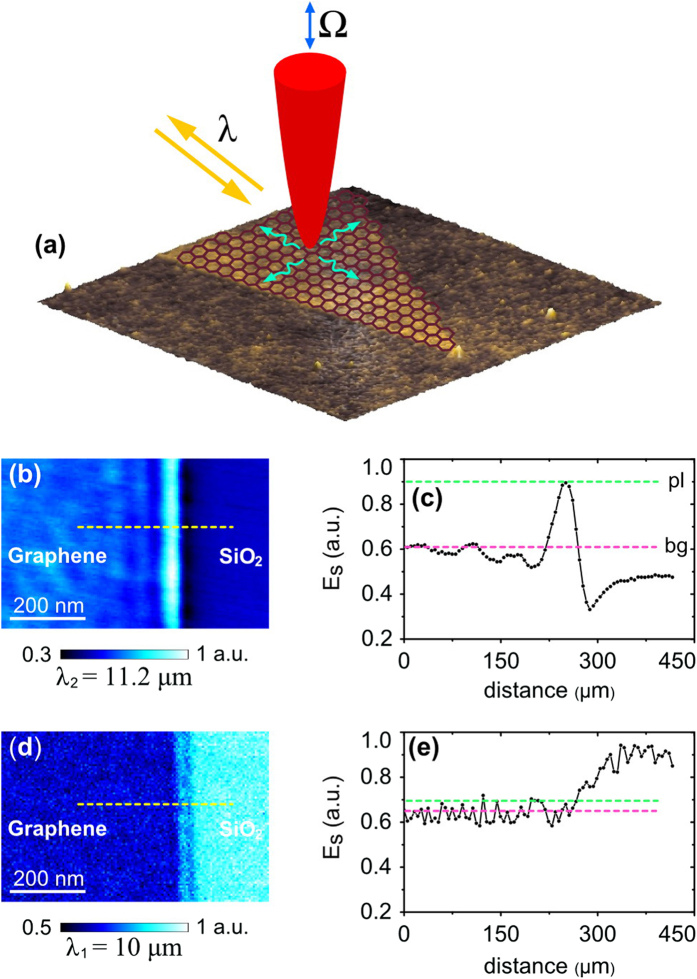
Illustration of the damping of graphene plasmons on silicon dioxide substrate at mid-infrared frequencies(a) A sketch of the principle behind scattering-type scanning near-field optical microscope (s-SNOM) measurements. (b,d) Optical near-field images of exfoliated graphene flakes, recorded at λ2 = 11.2 μm and λ1 = 10 μm, respectively. (c,e) Corresponding cross-sections along dotted yellow lines in images (b,d) which represent a distribution of the near-field across graphene-SiO2 boundary. Green and pink dotted lines mark GPs’ field magnitudes at the first maximum close to the boundary ((Es)pl), and inside the inner part of graphene flakes (background value, (Es)bg).